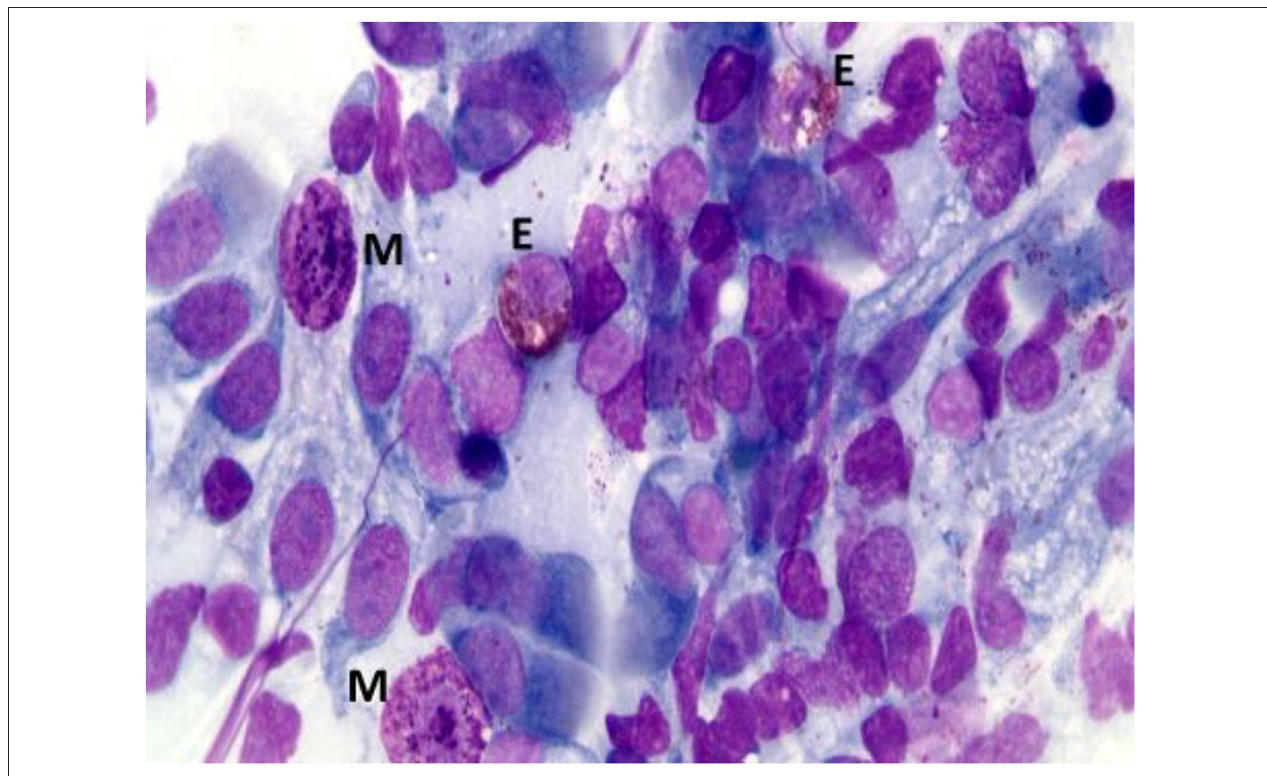
FIGURE 3 | Nasal cytology of NARESMA. E, eosinophil; M, mast cell; D, degranulation. MGG staining. Magnification